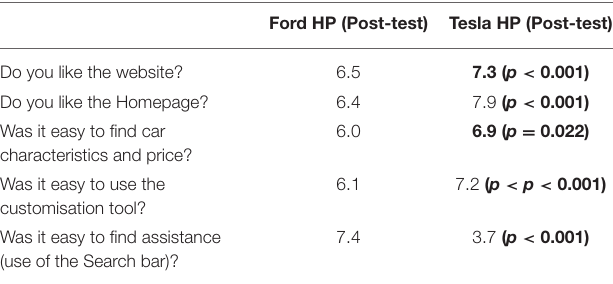
TABLE 7 | Results from the final survey expressed by means of average scores for each item (from 1 to 9).